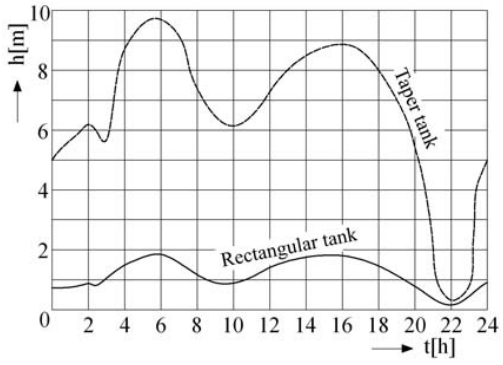
Figure 6. Water level fluctuation in elevated tanks.